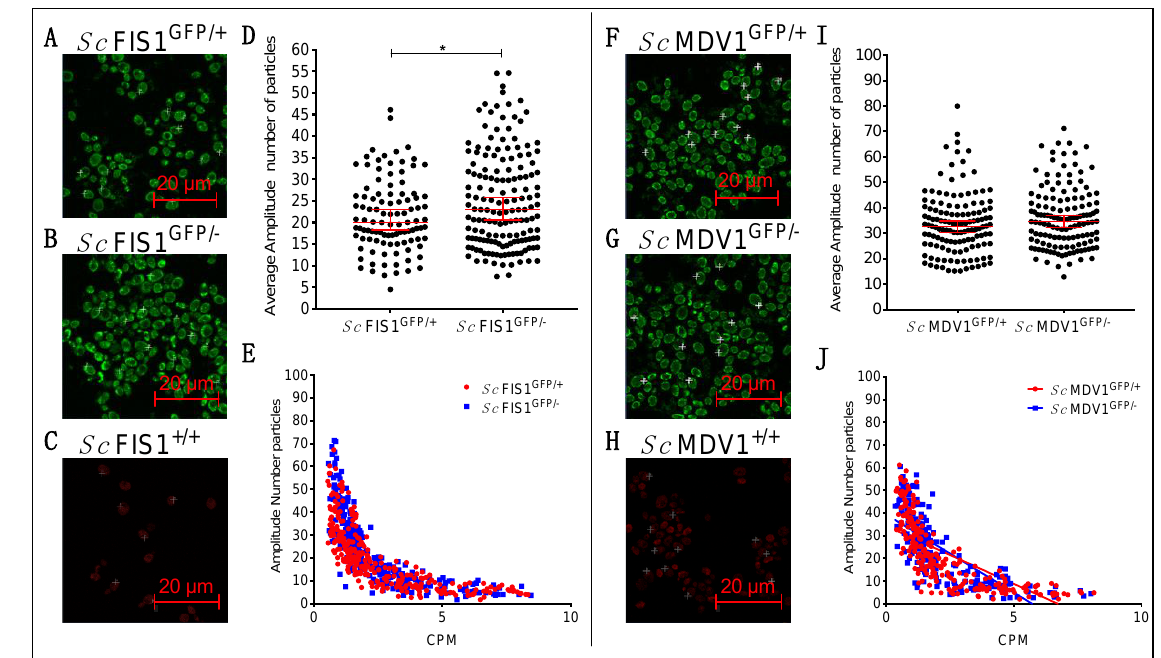
Figure 3. Measurement of Fis1p-GFP and Mdv1p-GFP abundance in yeast cells growing in non- fermentable carbon source. Sample images of Sc FIS1 GFP/+ ( A ), Sc FIS1 GFP/+ ( B ) and Sc FIS1 +/+ ( C ) obtained by imaging cells in the mid-logarithmic phase in media containing glycerol at positions indicated by the crosses (Scale bar = 20 µ m). Scatter plots ( D ) show the heterogeneity in molecule number in confocal volume measured in single cells of Sc FIS1 GFP/+ ( n = 103) and Sc FIS1 GFP/ − ( n = 158) cell populations. Linear regression graph ( E ) shows the correlation between the CPM and amplitude values, revealing no technical artefacts for FCS measurements taken in both cell lines ( Sc FIS1 GFP/+ , R 2 = 0.51 and Sc FIS1 GFP/ − , R 2 = 0.55). Sample images of Sc MDV1 GFP/+ ( F ), Sc MDV1 GFP/ − ( G ) and Sc MDV1 +/+ ( H ) were obtained from FCS measurements taken at positions indicated by the crosses on exponentially growing cells in media containing glycerol. Scatter plots show the heterogeneity in molecule number in confocal volume measured in single cells of Sc MDV1 GFP/+ ( n = 131) and Sc MDV1 GFP/ − ( n = 135) cell populations ( I ). Linear regression graph ( J ) shows the correlation between the CPM and amplitude values, revealing no technical artefacts for FCS measurements taken in both cell lines ( Sc MDV1 GFP/+ , R 2 = 0.51 and Sc MDV1 GFP/ − , R 2 = 0.54). Scale bar is at 20 µ m. Error bars show the 95% confidence intervals and the median value. Statistical significance was calculated using Mann-Whitney two-tailed t -test. * represents significance for p ≤